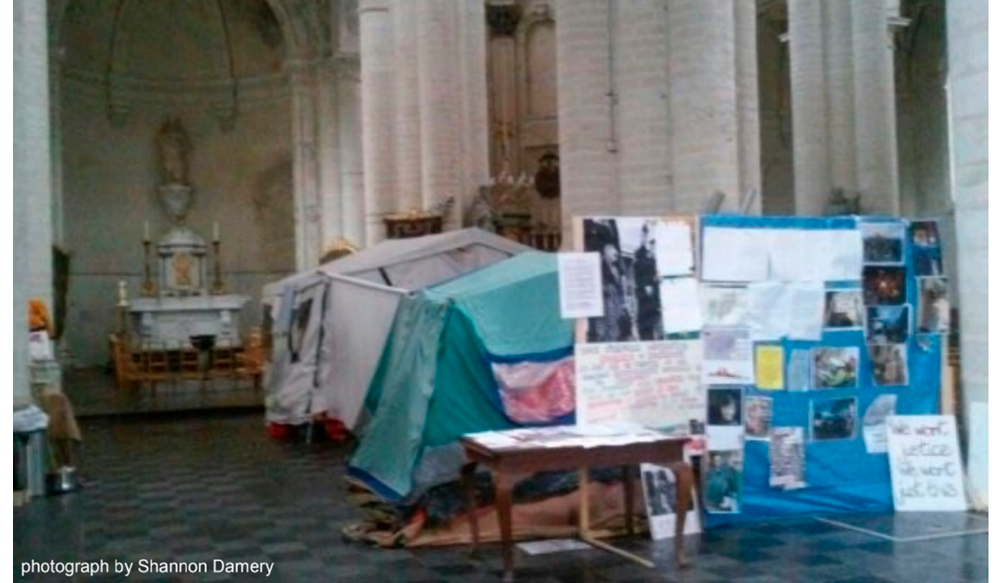
Figure 4 . Inside the church. 15 January 2015 © Shannon Damery. Figure 4. Inside the church. 15 January 2015 © Shannon